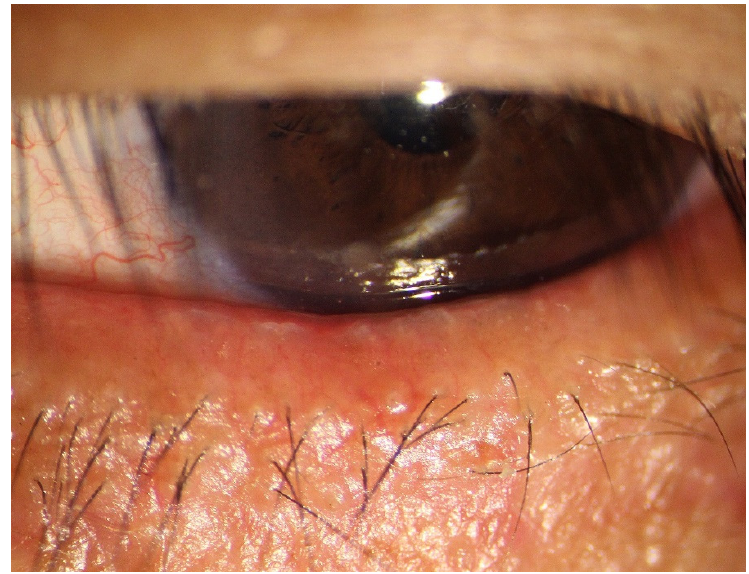
Figure 1. The slit-lamp photo of the Demodex infested eyelid. The photo showed marked diffuse hyperemia of lid margin, lid margin telangiectasia, and abnormal eyelashes with cylindrical dandruff.